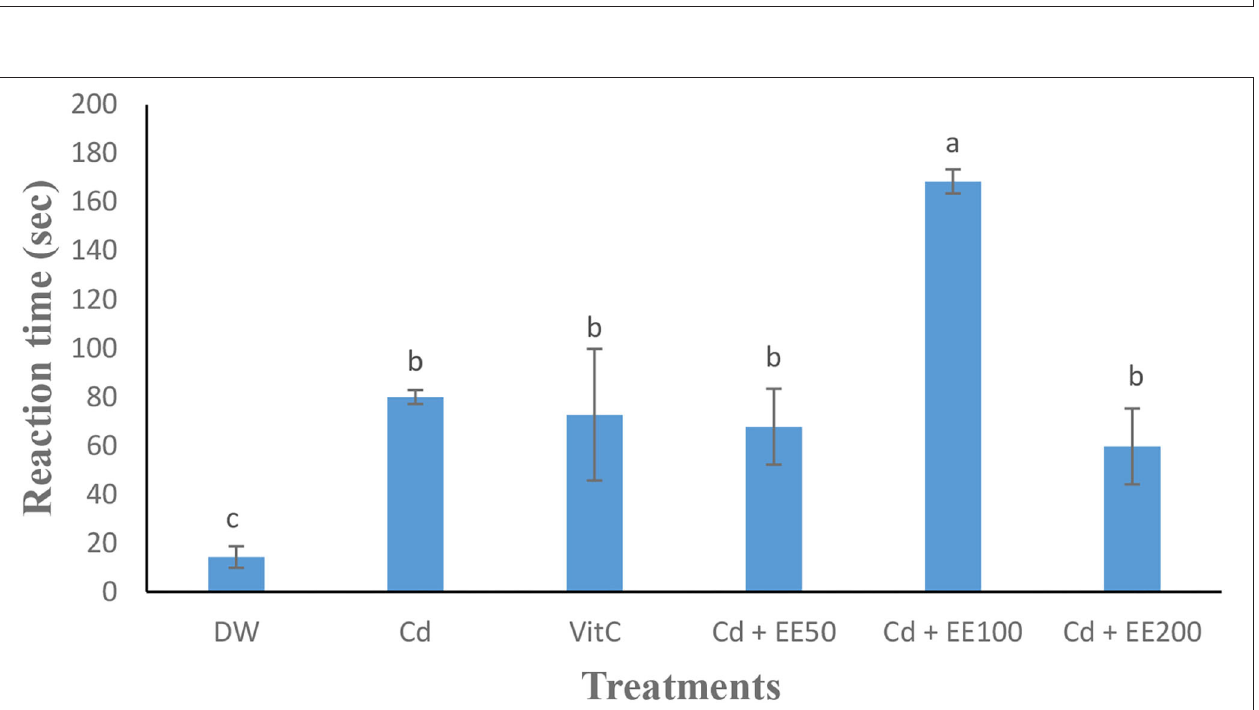
FIGURE 2 | Effects of different concentrations of ethanolic extract of Polygonum limbatum meism (EEPLM) on reaction time in male guinea pigs exposed to cadmium chloride. a, b, c: histogram values with the same letters are not significantly ( p > 0.05) different.